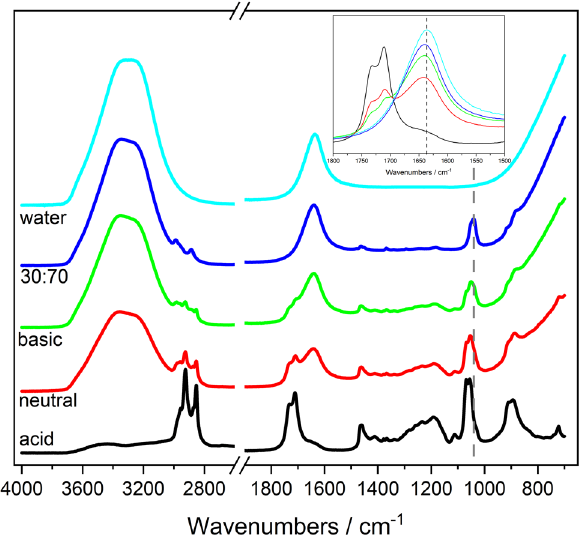
Figure 5. Spectra of the top (THF-rich) layer of THF-water mixtures separated using 1 M lauric acid under acidic (black), circum-neutral (red) and basic (green) conditions. THF-water mixtures were prepared using 30:70 THF:water (v/v) mixtures. The spectra of 30:70 THF:water (v/v) mixtures (without lauric acid) (blue) and the spectra of pure water (cyan) are also shown for comparison. The inset shows the carbonyl and water bending region of the spectra. The grey dashed line indicates the shift in the THF C–O stretch peak.